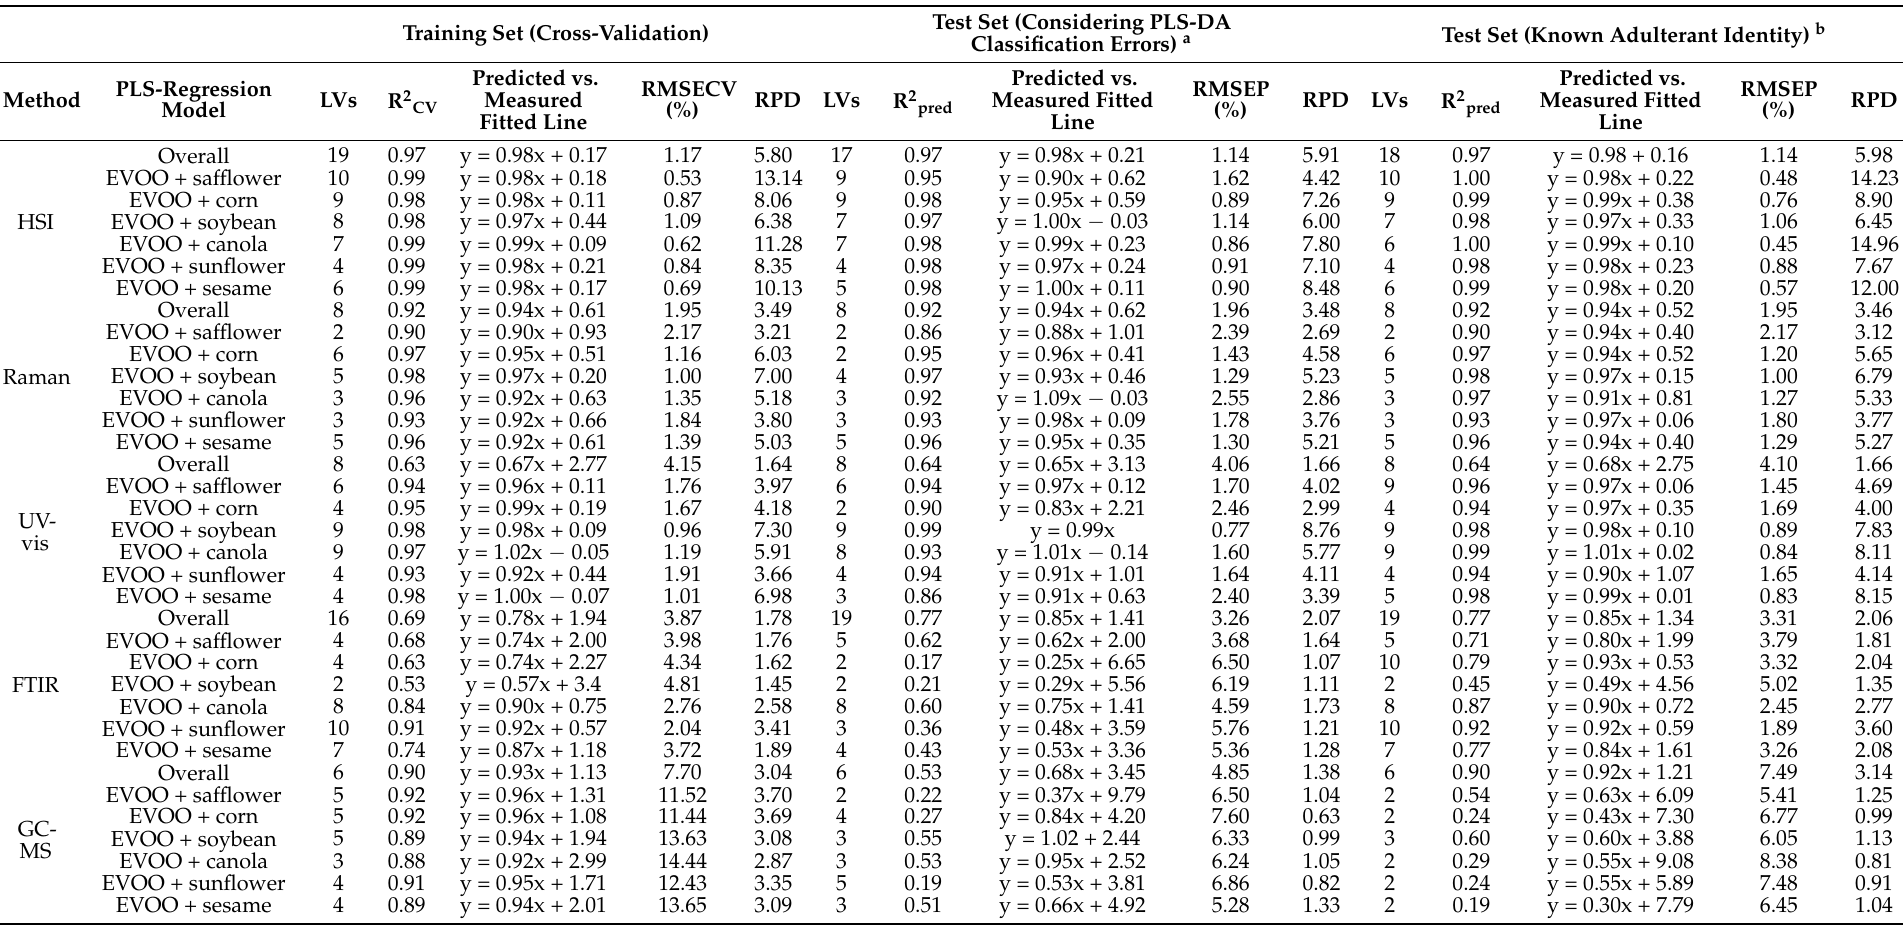
Table 5. Statistical parameters of PLS (partial least squares) regression for prediction of adulterant’s concentration (%) in olive oil using different techniques. Training Set